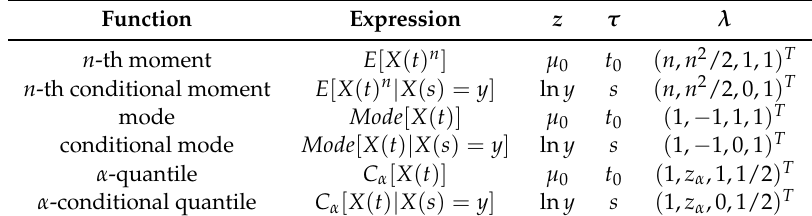
Table 1. Values used to obtain the n -th moment and the mode and quantile functions from G λ z α is the α -quantile of a standard normal